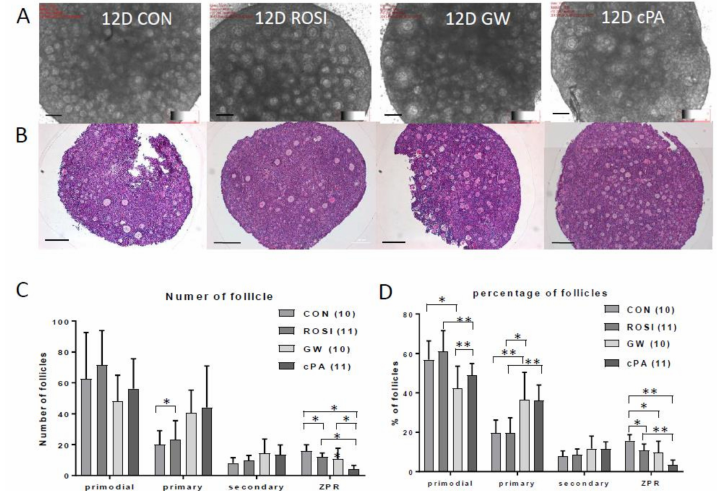
Figure 4. Ovarian histology showing follicle development at 12 days after treatment with PPAR γ modulators. ( A , B ) Bright field and HE staining of ovaries from in vitro cultures of 5-day-old ovaries treated with PPAR γ modulators for 12 days. Scale bar = 100 µ m. Number of follicles ( C ) and percentage of follicles ( D ) in each stage are shown from HE staining. Numbers in parentheses of the legend indicate numbers of ovaries. ZPR, zona pellucida remnant. *, ** indicate significant di ff erences between groups, p < 0.05, 0.001.